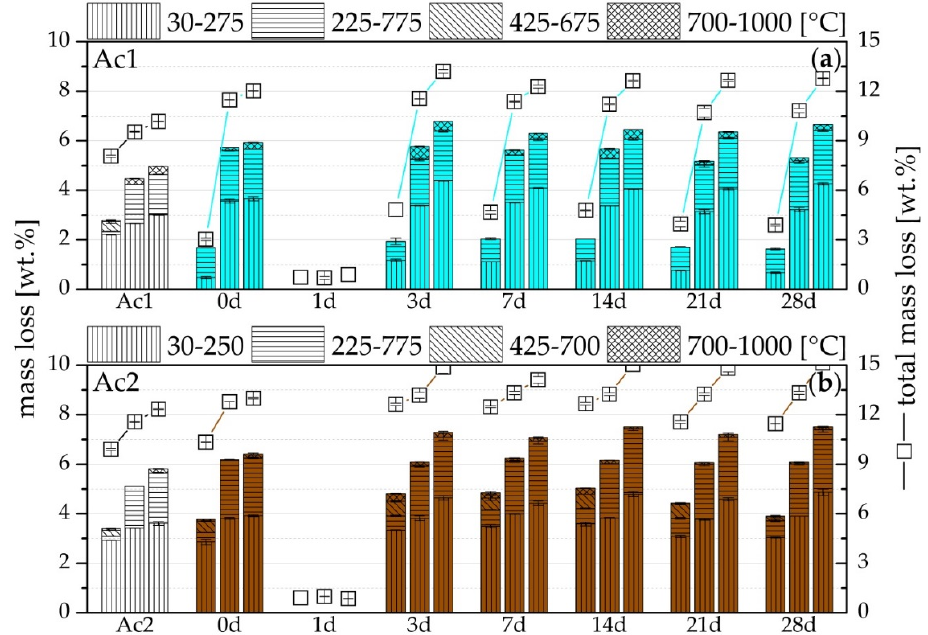
Figure 4. Mass loss by TG of ( a ) Ac1 and ( b ) Ac2 after seven, 28 and 90 days (from left to right per test) after the beginning of the hydration of the references (without retarder) and the reactivated mixtures after seven different periods of retardation with 1%R.